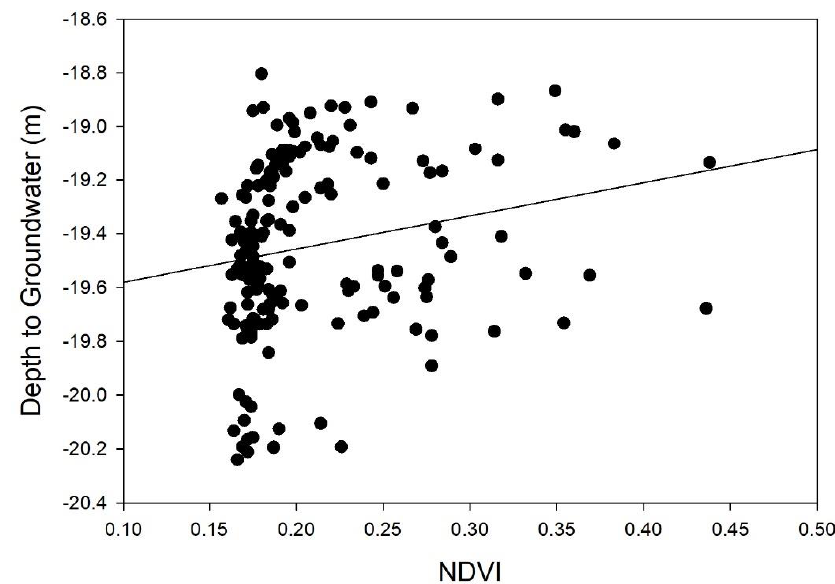
Figure 6. Relationship between depth to groundwater ( G ) and NDVI .